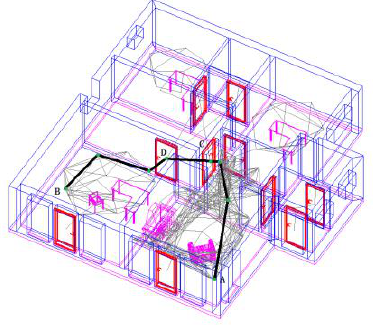
Figure 13. The shortest path from A to